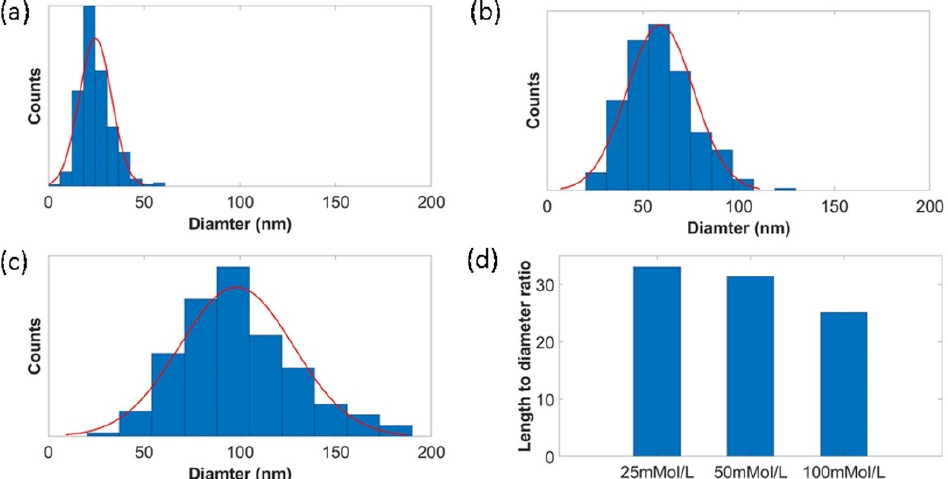
Figure 2. Diameter distribution of ZnO nanowires under different concentrations: ( a ) 25 mmol/L, ( b ) 50 mmol/L, ( c )100 mmol/L, and ( d ) length-to-diameter ratio of each concentration.